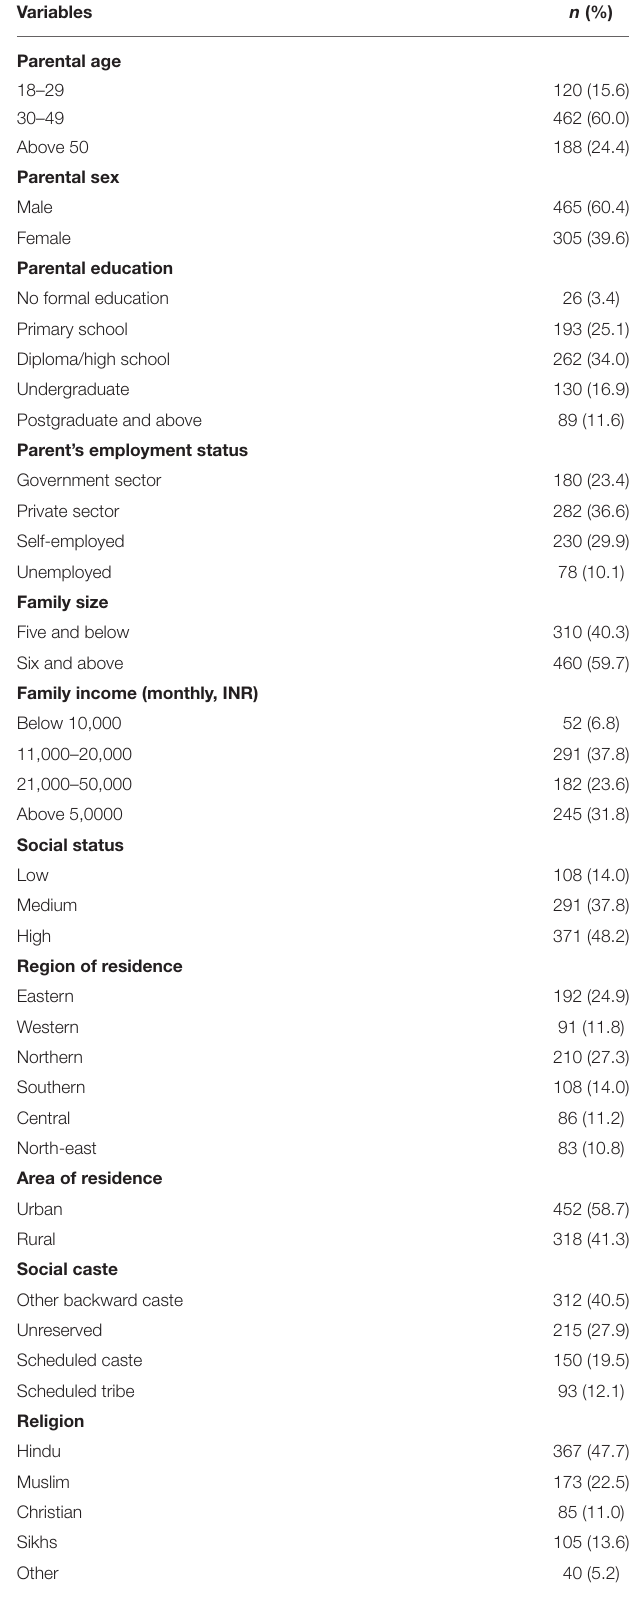
TABLE 1 | Sociodemographic characteristics of the study respondents ( N =